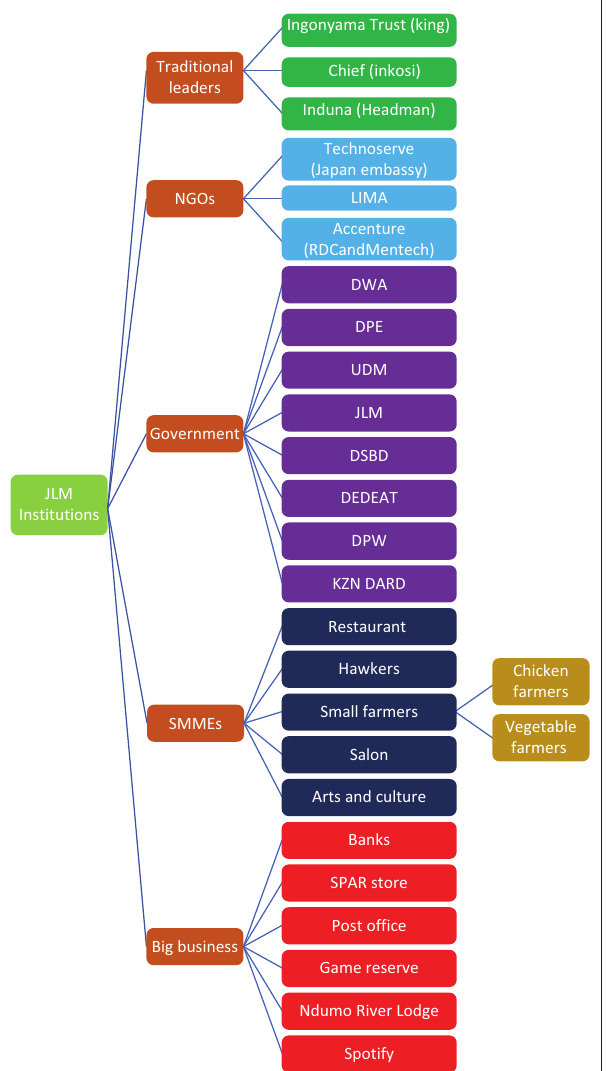
FIGURE 3: Summary of Matatiele Local Municipality’s small, medium and micro enterprises social and institutional